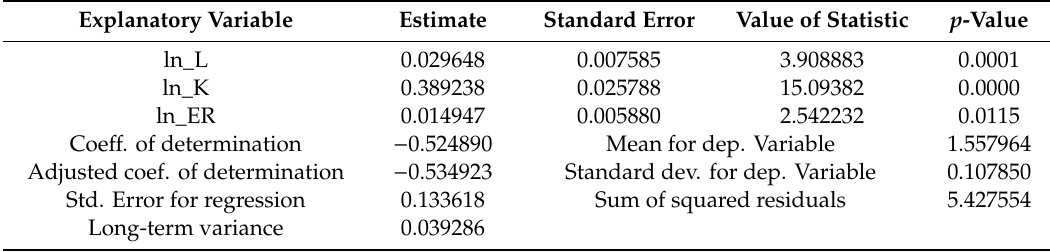
Table 5. Panel data model based on FMOLS estimators to explain global competitiveness index (GCI) growth in the EU countries and UK (2007–2019).